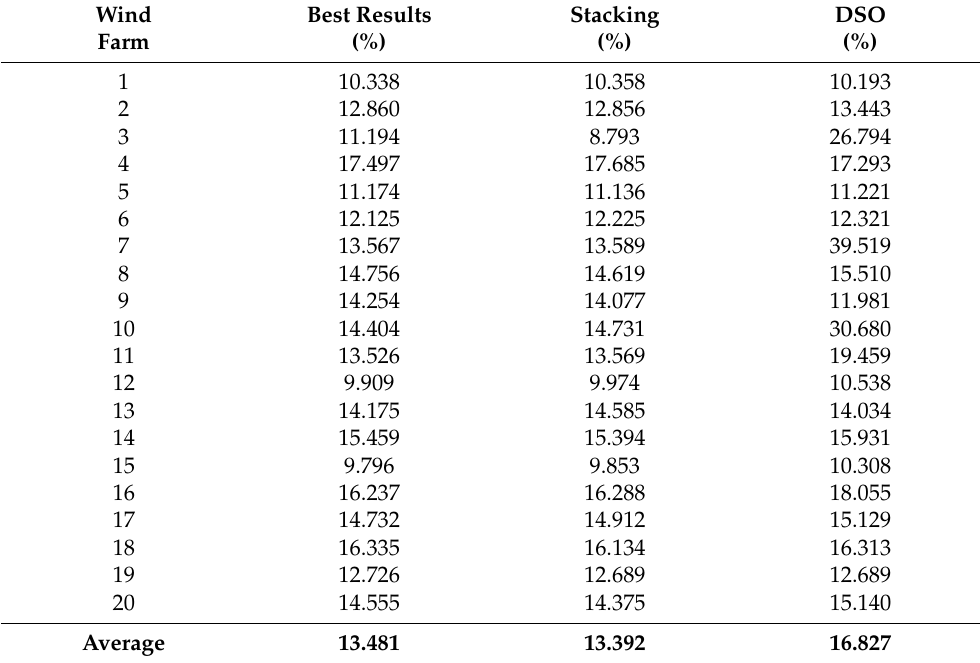
Table 7. RRMSE for stacking approach: 1 year training, 6 months